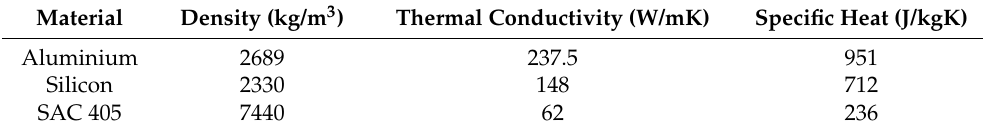
Table 1. Properties of materials [4,19].